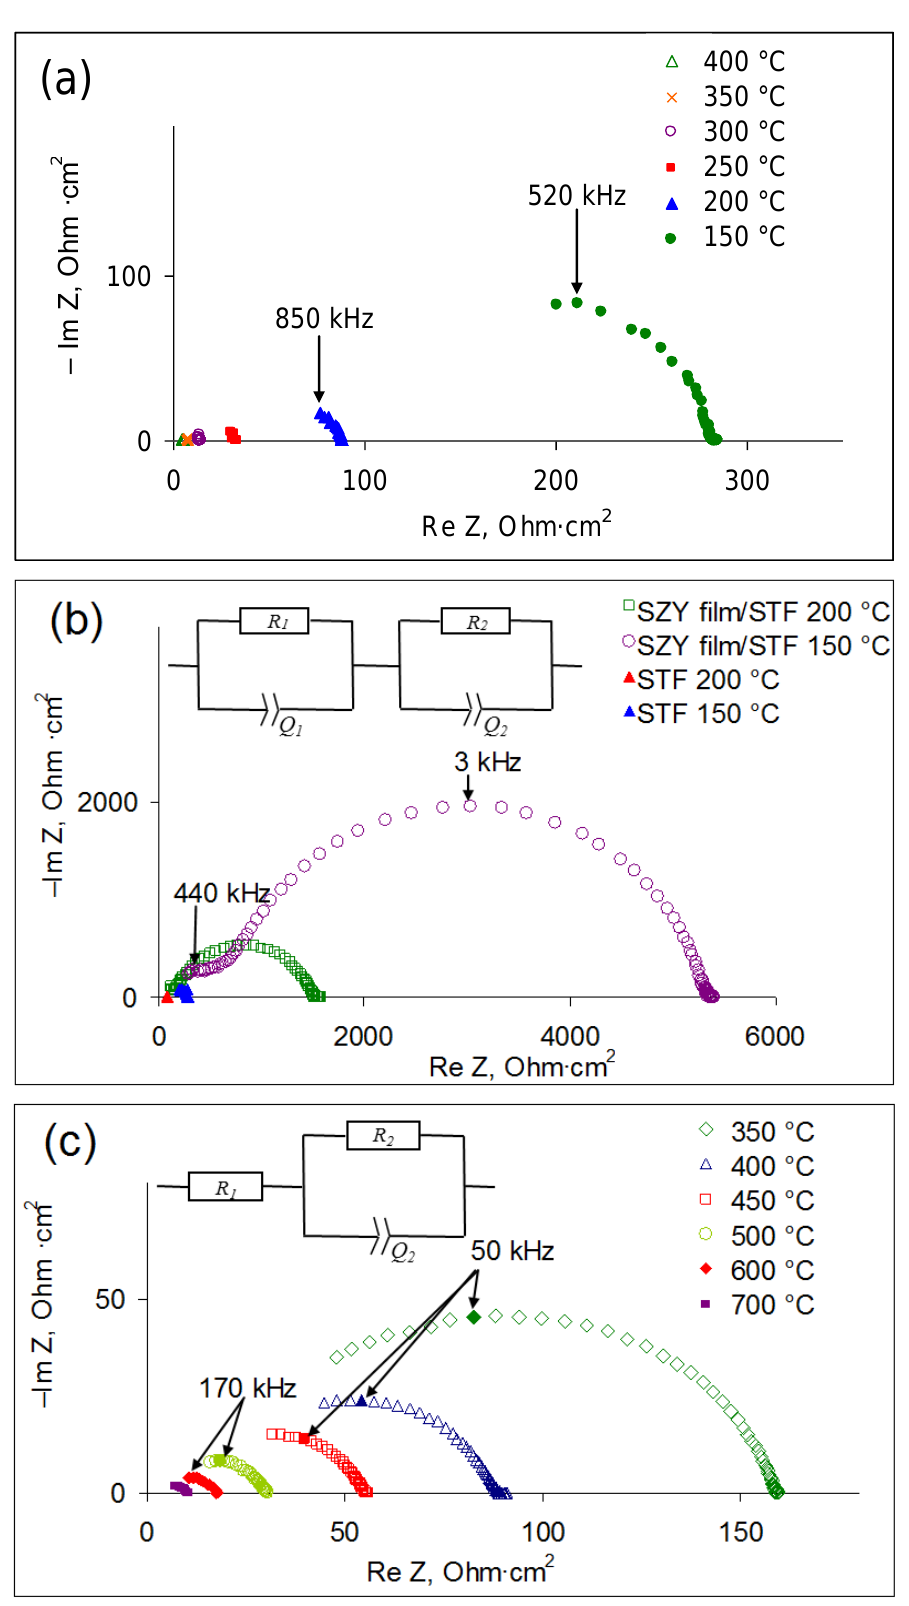
Figure 6. Impedance spectra of ( a ) Pt/STF/Pt cell, and Pt/SZY-film/STF/Pt cell with the 1 mm thick film at ( b ) 150 – 200 °C and ( c ) 350 – 700 °C. All spectra were measured in air (pH 2 O = 40 Pa). Electrical resistance of the film (R film ) was calculated by subtracting the resistance of STF from the Pt/SZY-film/STF/Pt cell resistance, the resistance of the film grain boundaries